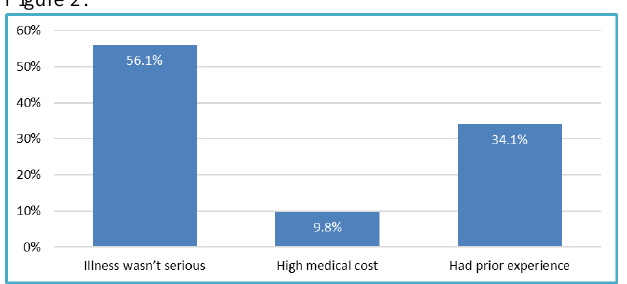
Figure 2 : Reasons indicating why the study population practices self-medication instead of seeing a doctor